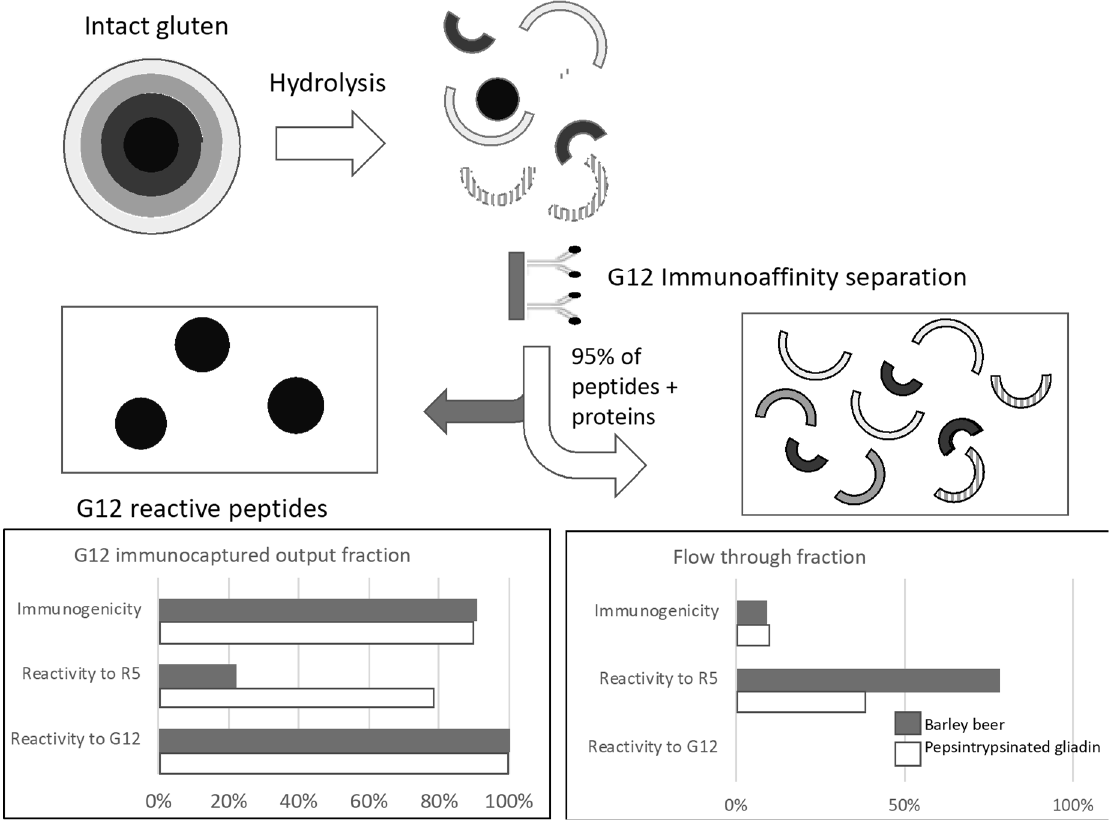
Figure 2. Diagram of the workflow for the selective capture of dominant celiac immunoactive peptides from hydrolyzed gluten. Semicircles with different colors represent peptides with epitopes not recognized by G12. Circular forms represent peptides with epitopes recognized by G12. Protein content by Bradford, T‐cell reactivity (T‐cell division and IFN‐γ production), and G12 and R5 competitive ELISA were addressed to the different fractions.